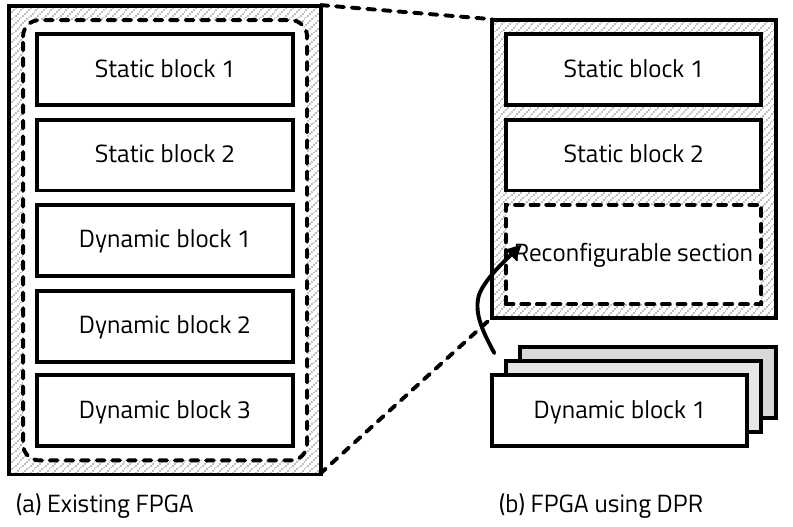
Figure 3. Blocks configured in existing FPGA and FPGA using dynamic partial reconfiguration